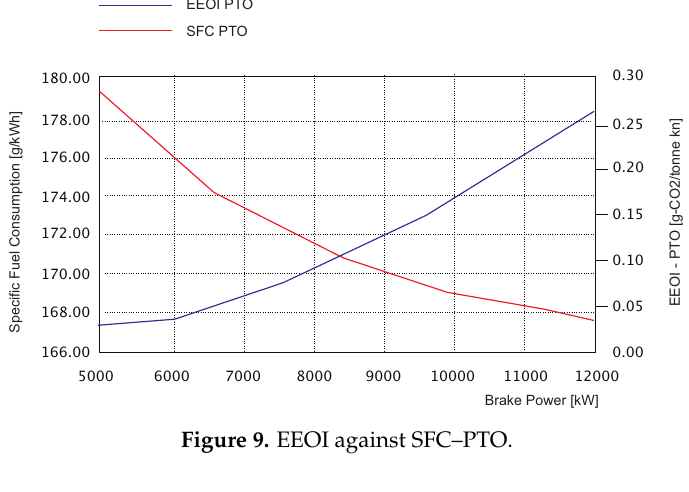
Figure 9. EEOI against SFC–PTO.